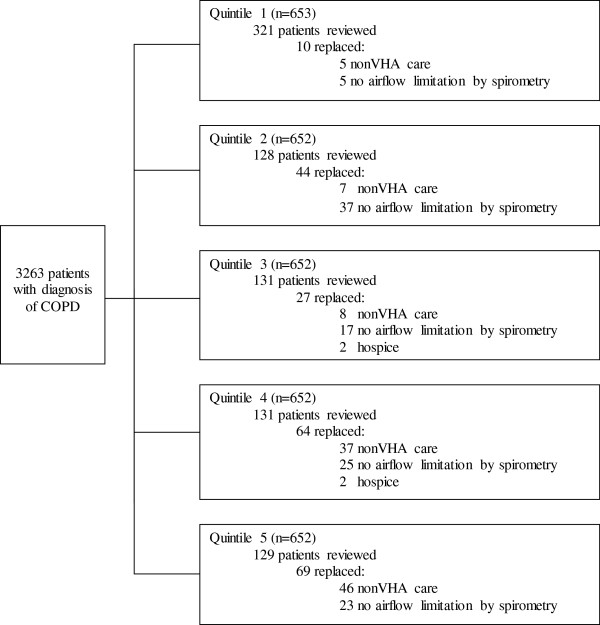
Patient selection diagram. Patients were selected by a modified stratified systematic sampling: every other patient in the first quintile with the greatest COPD-related healthcare costs and every fourth patient in the remaining quintiles. If a patient received primary or pulmonary care from non-VA providers, airflow limitation (FEV1/FVC < 0.7) was not present on spirometry, or if they were in hospice care, they were excluded and replaced by the next patient on the rank list.